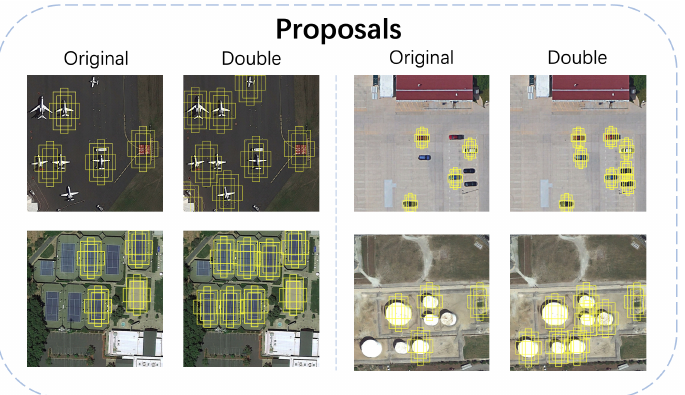
Figure 7. A schematic diagram of double